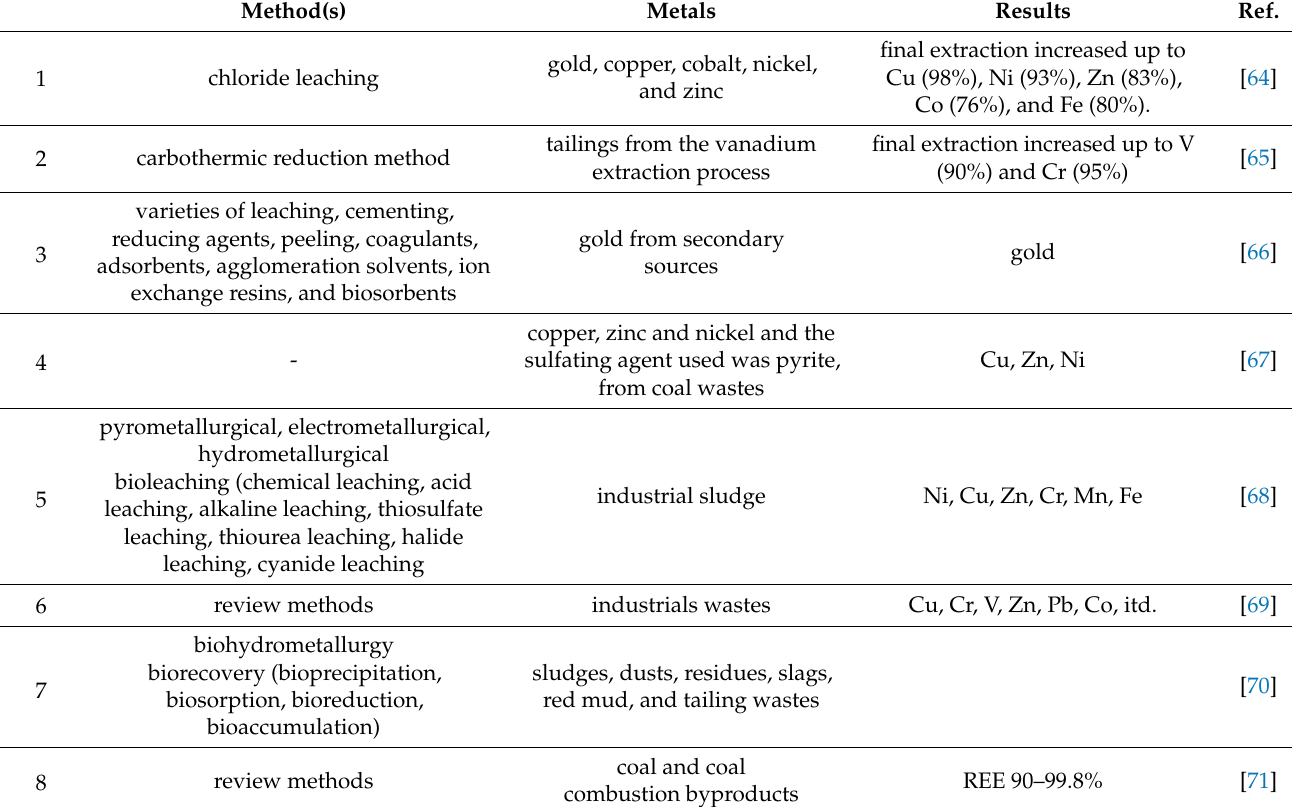
Table 6. An overview of some researched methodologies for extraction of useful elements from mining